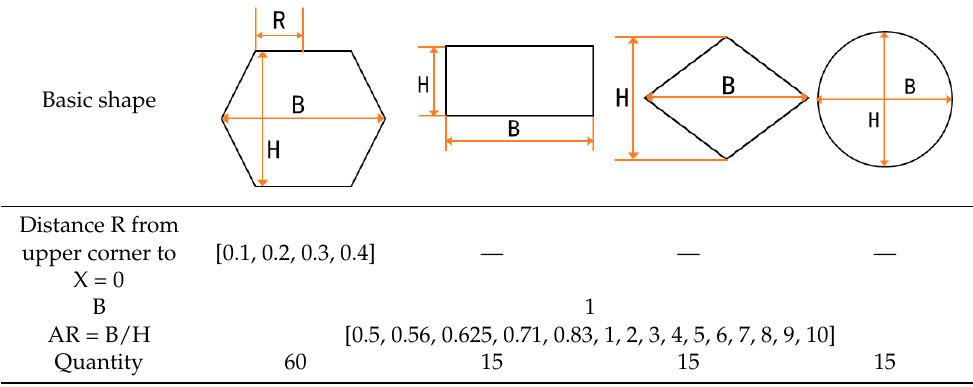
Figure 7. Sketch of the two-dimensional (2D) computational domain.